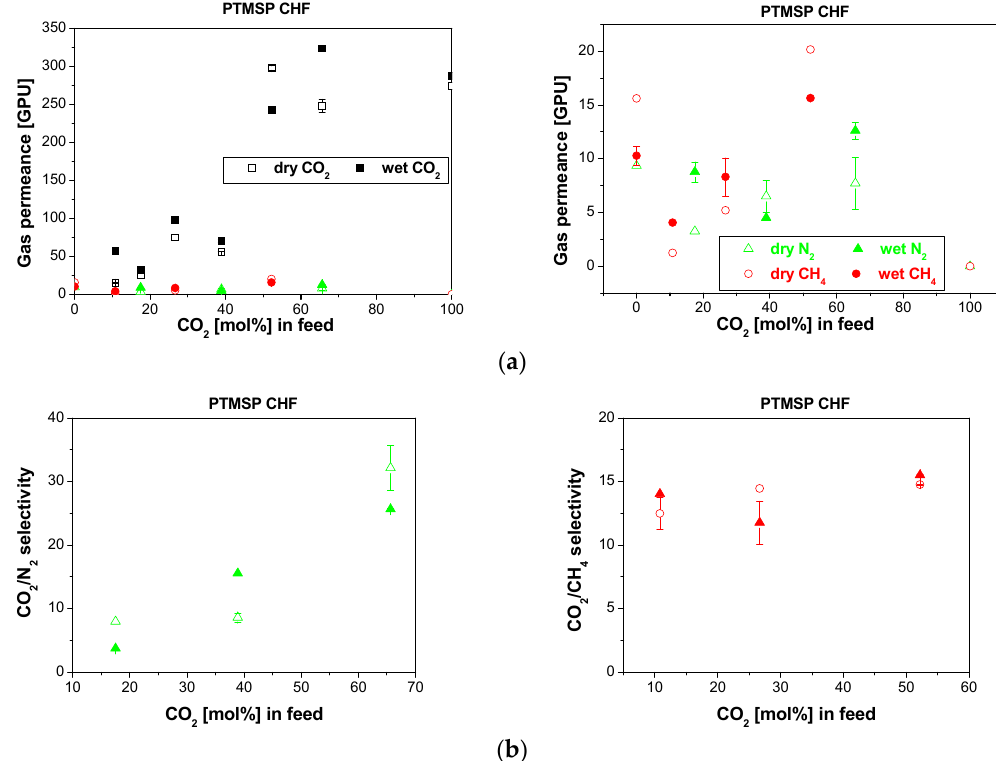
Figure 4. Gas permeance ( a ) and selectivity ( b ) obtained for the separation of CO 2 /N 2 (left) and CO 2 /CH 4 (right) mixtures through the PTMSP/P84 CHF membrane in dry (void symbols) and wet (full symbols). The right side of figure ( a ) shows the trend in the slow gas (N 2 , CH 4 ) permeance. The behavioral trend observed in Figures 3 and 4 was opposed to that of the IL ‐ CS/PSf CHF membrane in Figure 5, where the presence of water vapor in the feed increased the CO 2 permeance while diminishing the fluxes of CH 4 and N 2 , probably because of swelling of the IL ‐ CS matrix, thus revealing the hydrophilic nature of the selective IL ‐ CS layer [29].